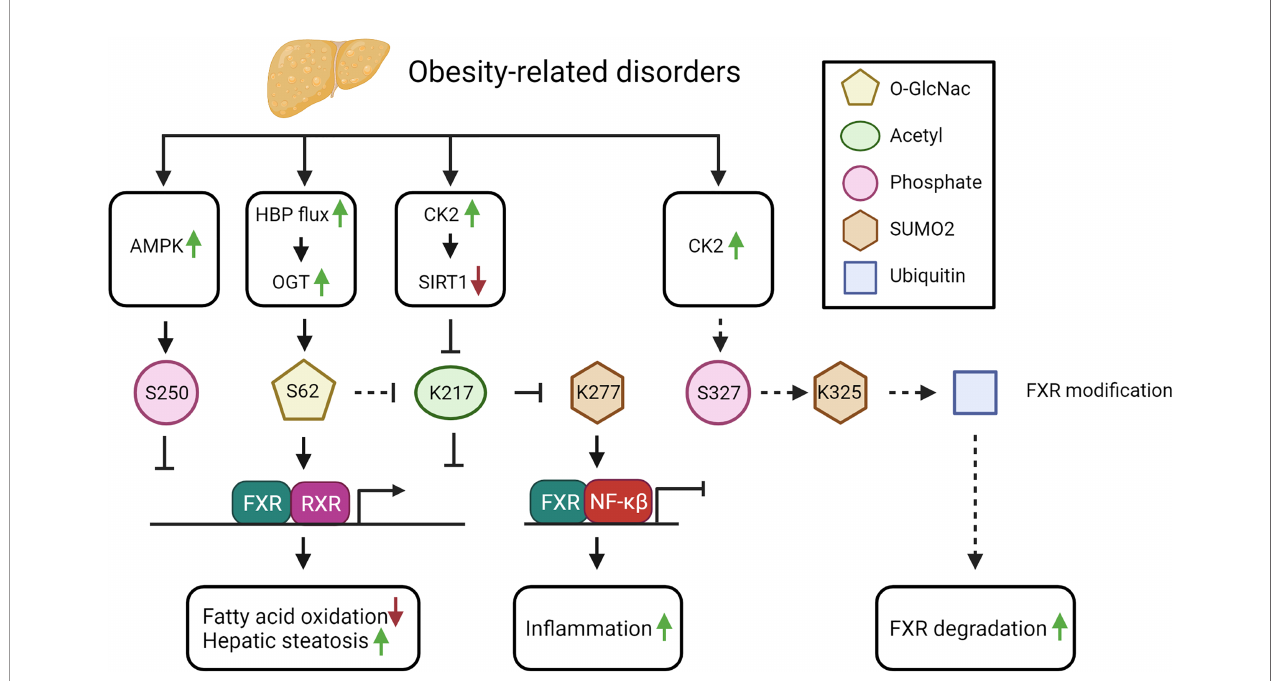
FIGURE 3 | The potential impact of FXR PTMs in obesity-related disorders (see text for explanation). Solid arrows indicate demonstrated relations and/or interactions, dashed lines indicate predictions inferred from the described molecular